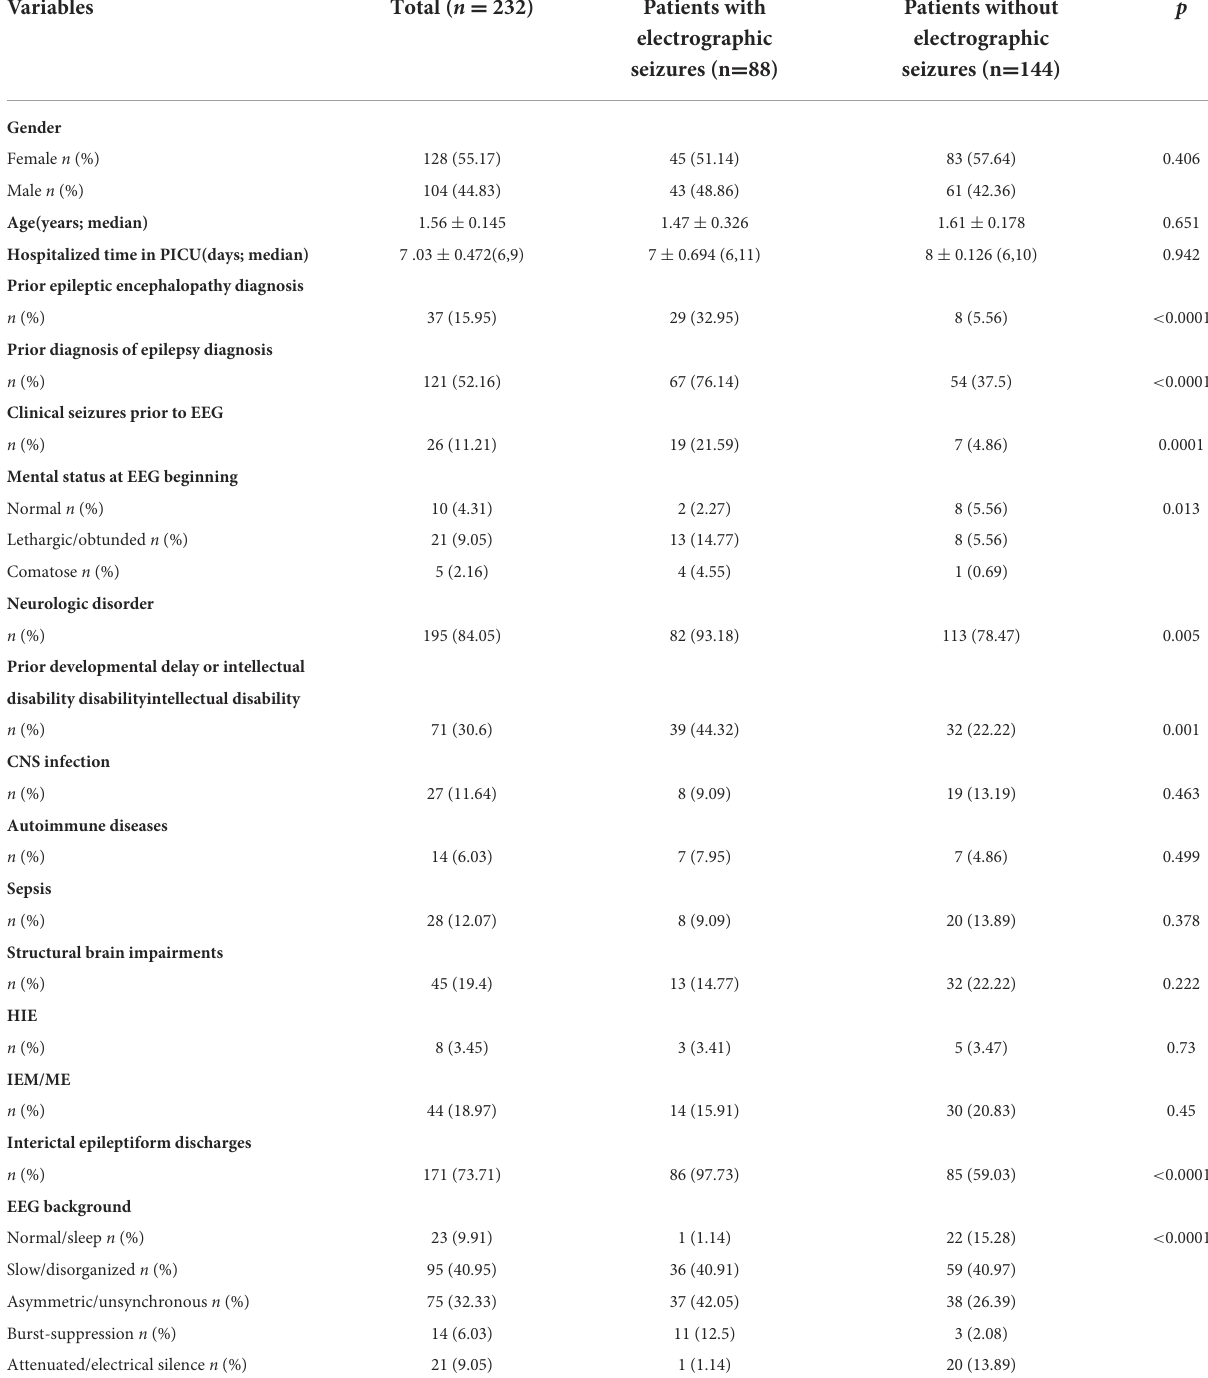
TABLE 1 General and clinical factors associated with electrographic seizures. Variables Total ( n = 232) Patients with